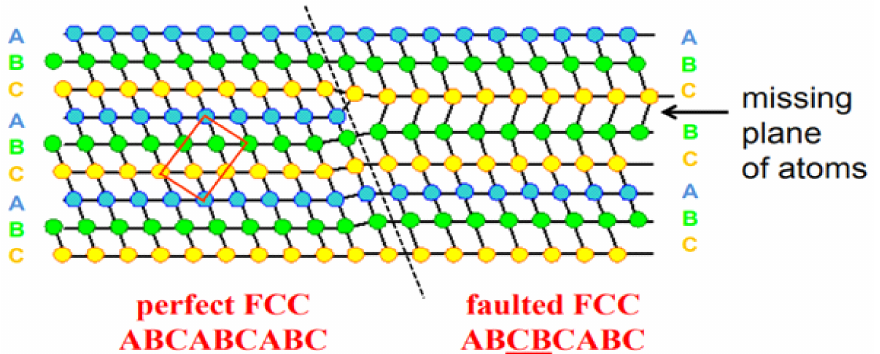
Figure 1. Schematic diagram showing the normal sequence of stacking (111) planes, ABCABCABC in the fcc crystal to that of missing out a plane so that the sequence changes to ABCBCABC, the stacking fault line being hcp